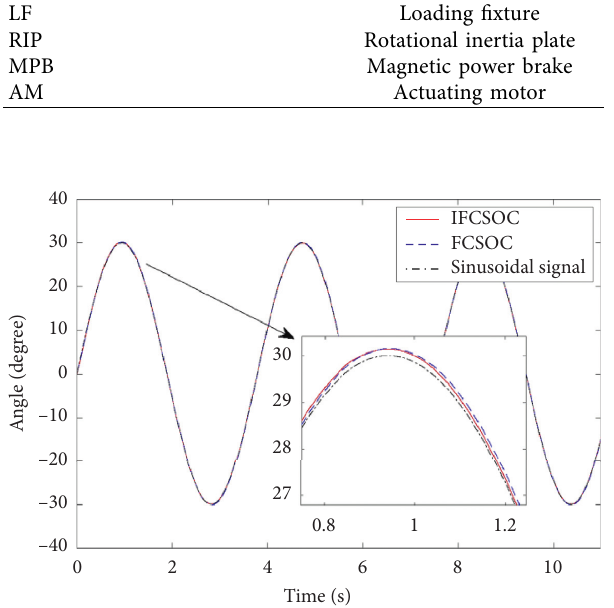
Figure 9: Comparison diagram of sinusoidal tracking curves.